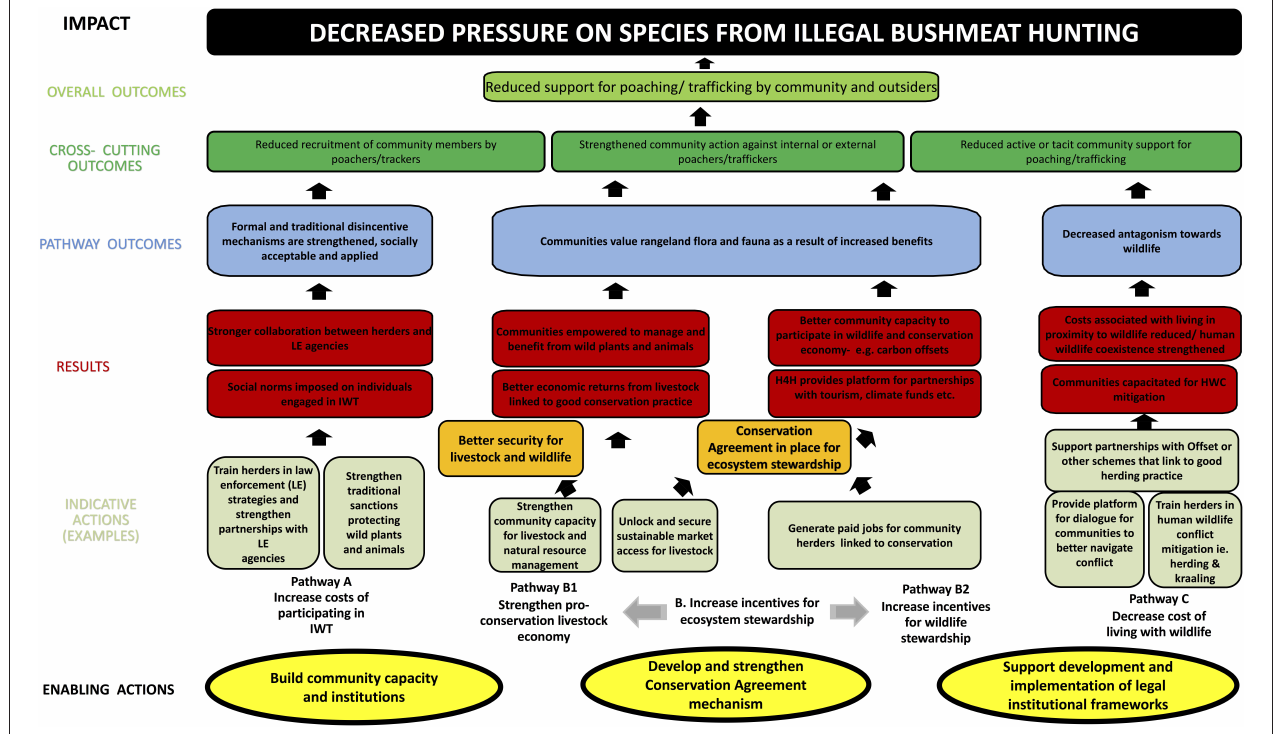
FIGURE 1 | Theory of Change (ToC) developed for the Herding 4 Health (H4H) model to identify the role agropastoral communities can play in addressing illegal wildlife trade. The ToC was developed from a series of stakeholder workshops between September and December 2018. A ToC validation workshop was held in March 2019 in Maun, Botswana which included government representatives from relevant ministries, NGO’s, community-based organizations and private sector